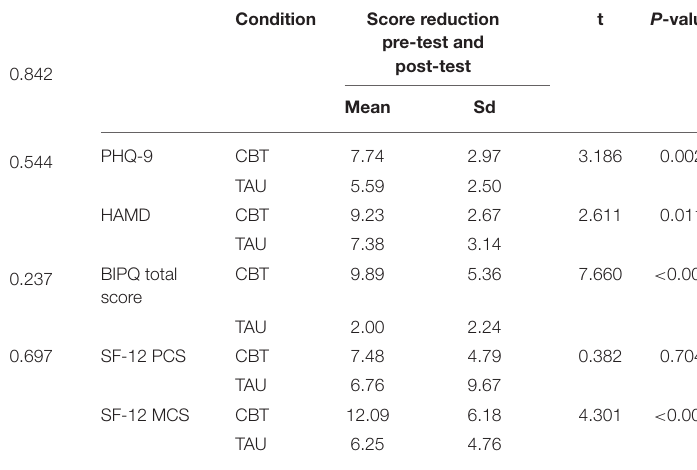
TABLE 3 | Comparison of score reduction in PHQ-9, HAMD BIPQ and SF-12 in CBT group and TAU